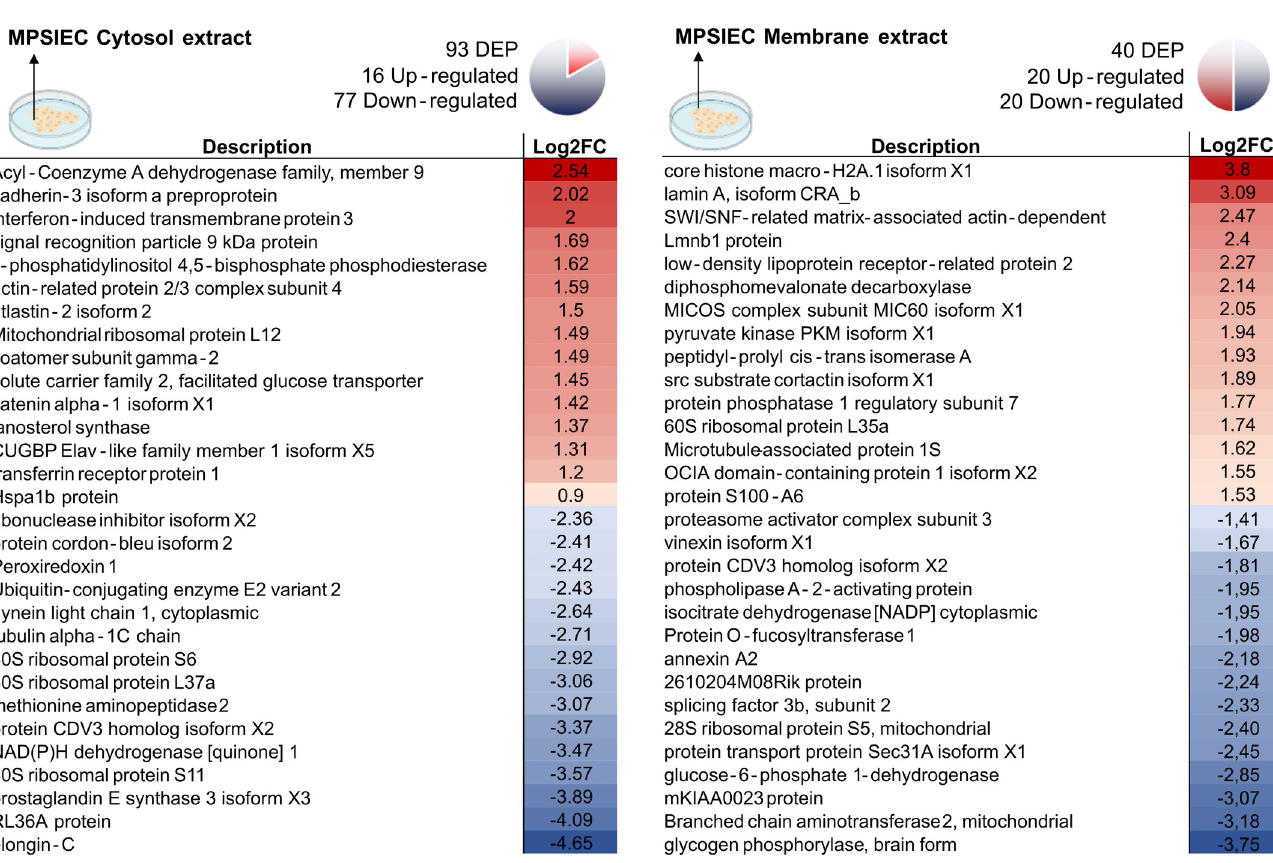
Fig 5. Differentially expressed proteins in MPSIEC after incubation with FhNEJ. The top 15 proteins with highest (represented in red) or lowest (represented in blue) fold change within the MPSIEC membrane and cytosol extracts are shown. Icons created with BioRender.com.